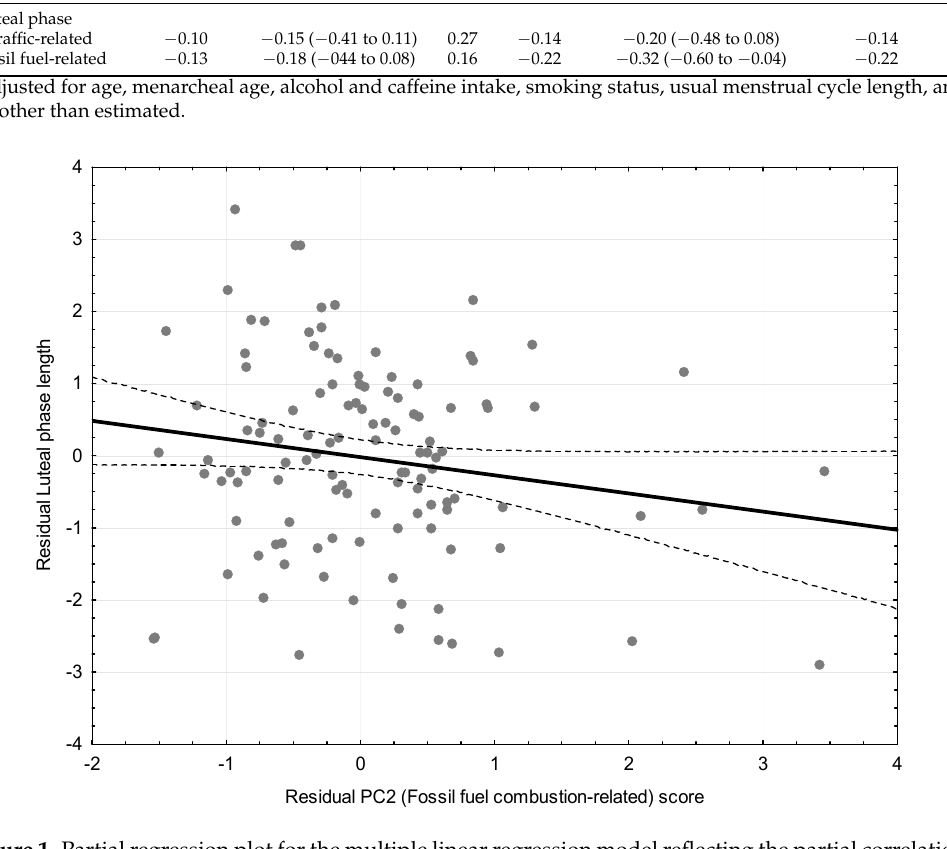
Figure 1. Partial regression plot for the multiple linear regression model reflecting the partial correlation coefficient between Fossil fuel combustion-related air pollutant scores (PC2) and luteal phase length after adjustment for age, menarcheal age, alcohol and caffeine intake, smoking status, usual menstrual cycle length, and PC1. Traffic-related air pollutant scores (r = − 0.22, p = 0.02). To facilitate the visual assessment of the scatter of points around the line, the 95% confidence intervals were shown. The solid line represents the regression line and the dotted lines stand for the regression lines’ 95% confidence intervals.